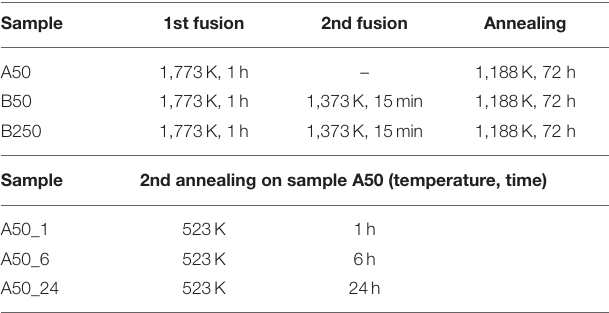
TABLE 2 | Synthesis protocols applied to the samples reported in this